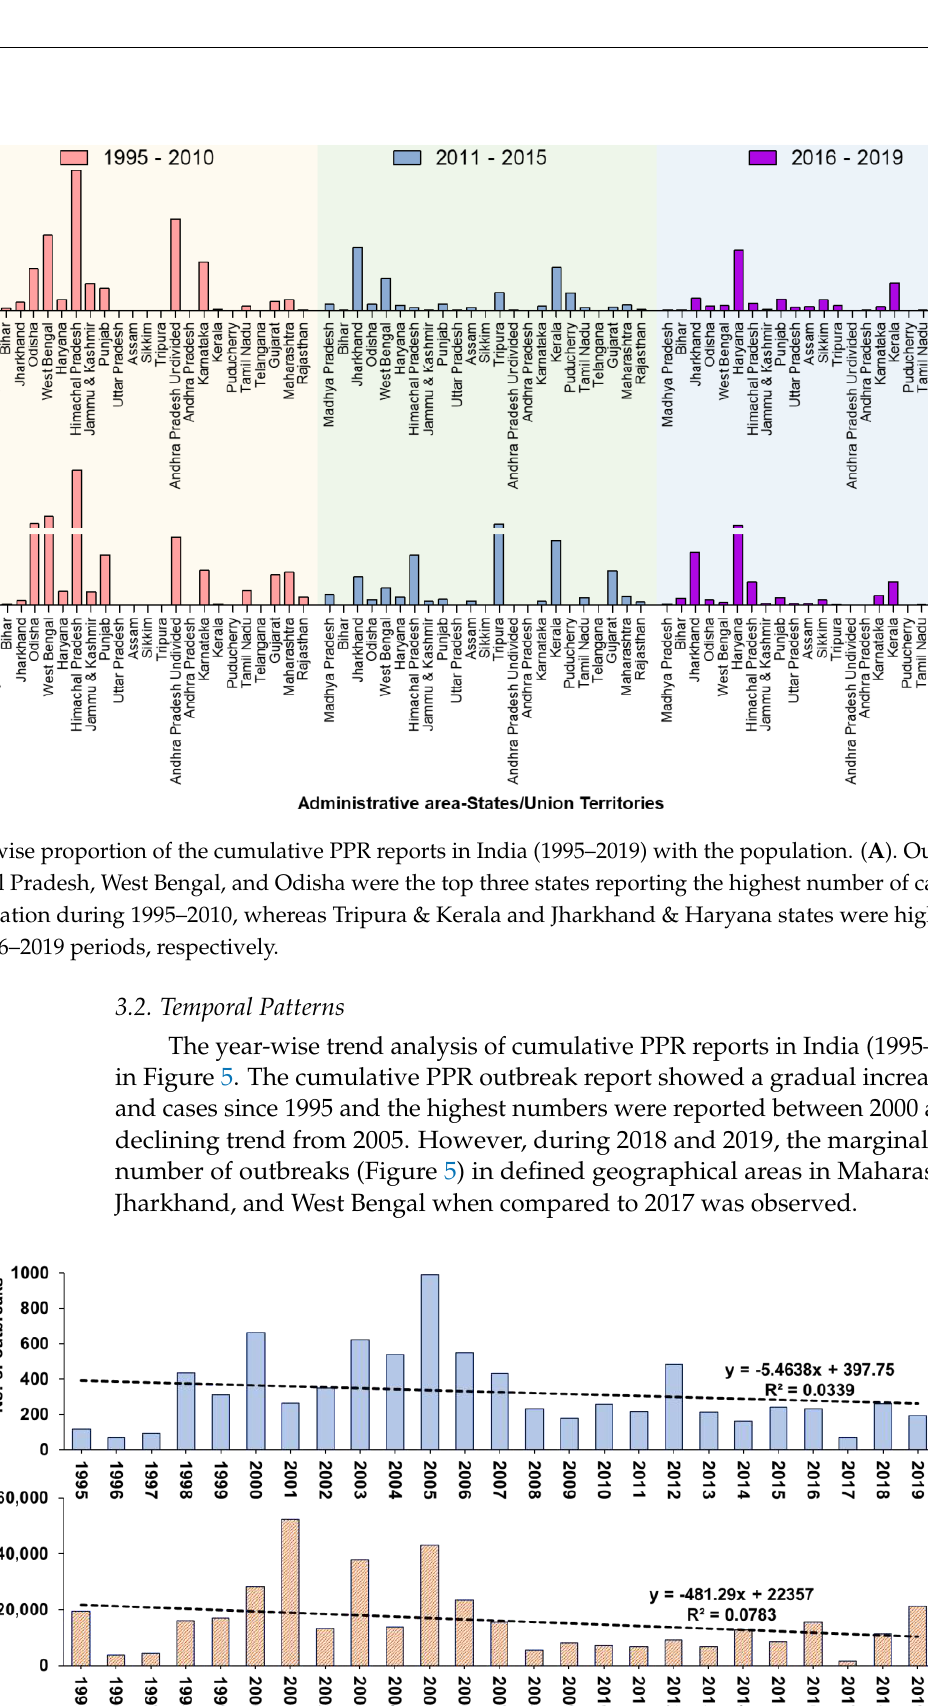
Figure 3. Dispersion analysis of the cumulative PPR reports in India (1995–2019). ( A ). State/Zone- wise ( B ). Species-wise. The mean cases per outbreak with the measure of the variation was calcu- lated. C-Central zone; E-East zone; N- North Zone; NE-North-East Zone; S-South Zone; W-West zone. The highest mean cases per outbreak were observed in Gujarat, followed by Himachal Pra- desh, Rajasthan, with the highest in sheep and goats in the West and North zone, respectively.